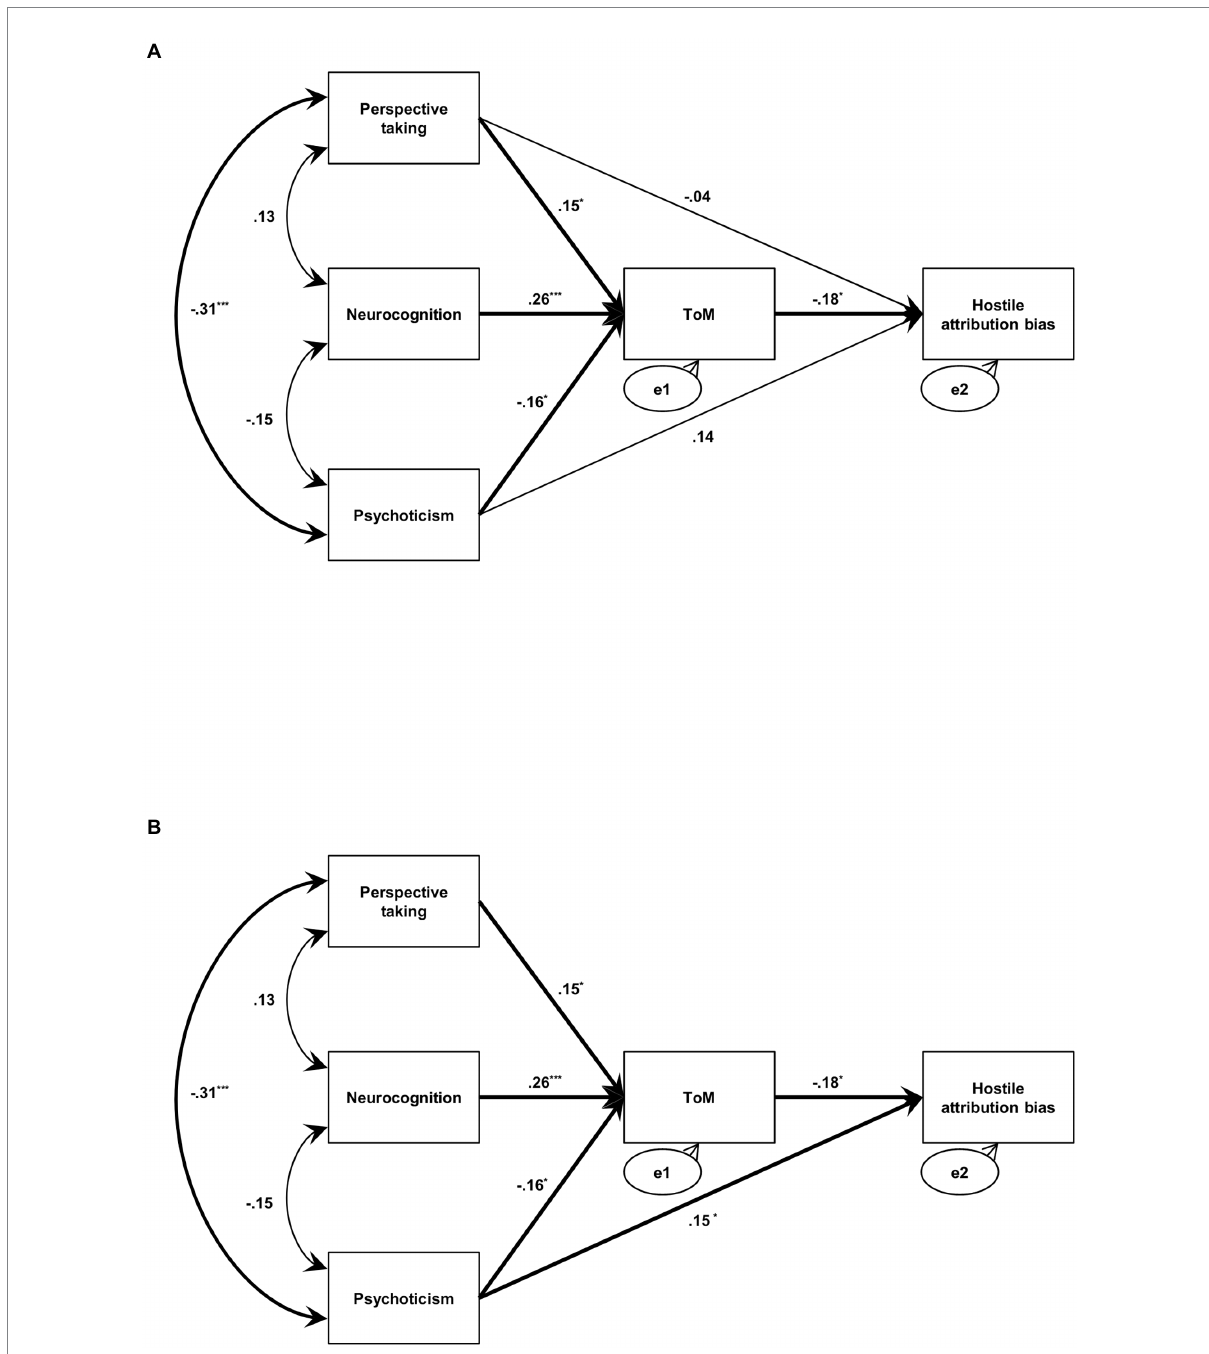
FIGURE 1 Basic model showing ToM as a mediator of the relationship. (A) Modified model. (B) * p < 0.05; ** p < 0.01; *** p < 0.001. Single-headed arrows indicate standardized regression weights; double-headed arrows indicate correlations. ToM, Theory of